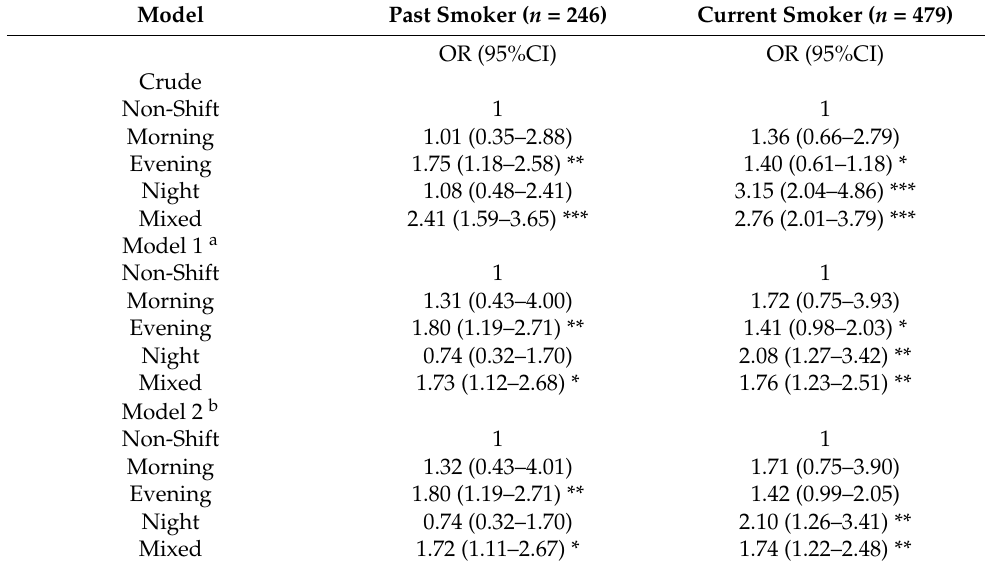
Table 3. Multinomial logistic regression of associations between shift schedule type and smoking status stratified according to past and current